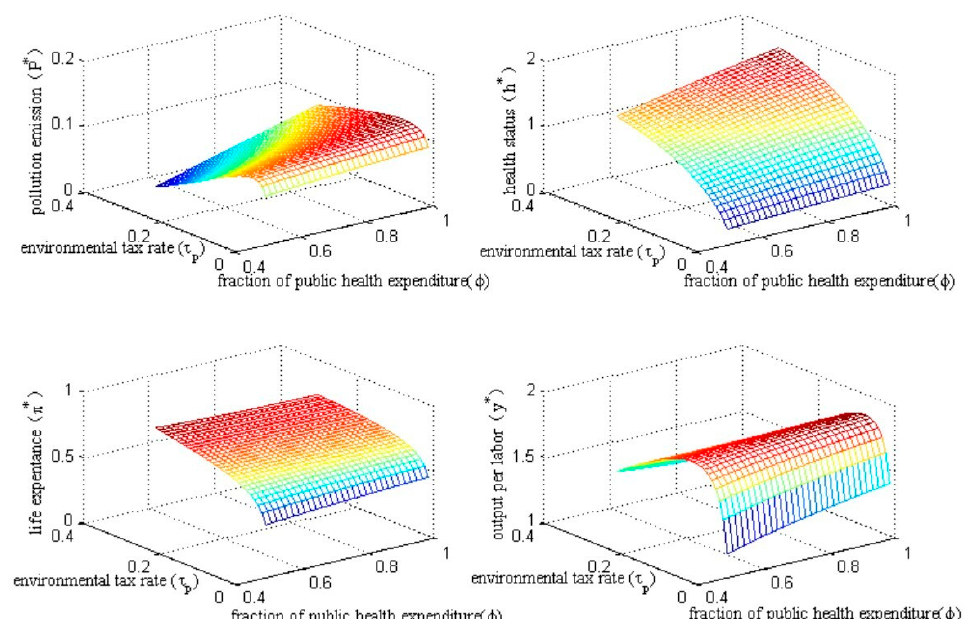
Figure 9. Impacts from the combination of 𝜏 (cid:3043) and 𝜙 .